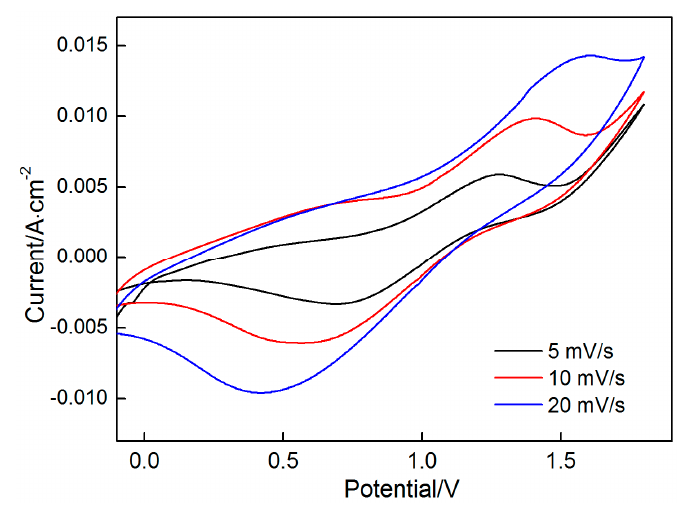
Figure 1. Cyclic voltammograms on graphite flake in 0.14 M MnSO 4 electrolyte at varying scan rates of 5, 10, 20 mV/s.